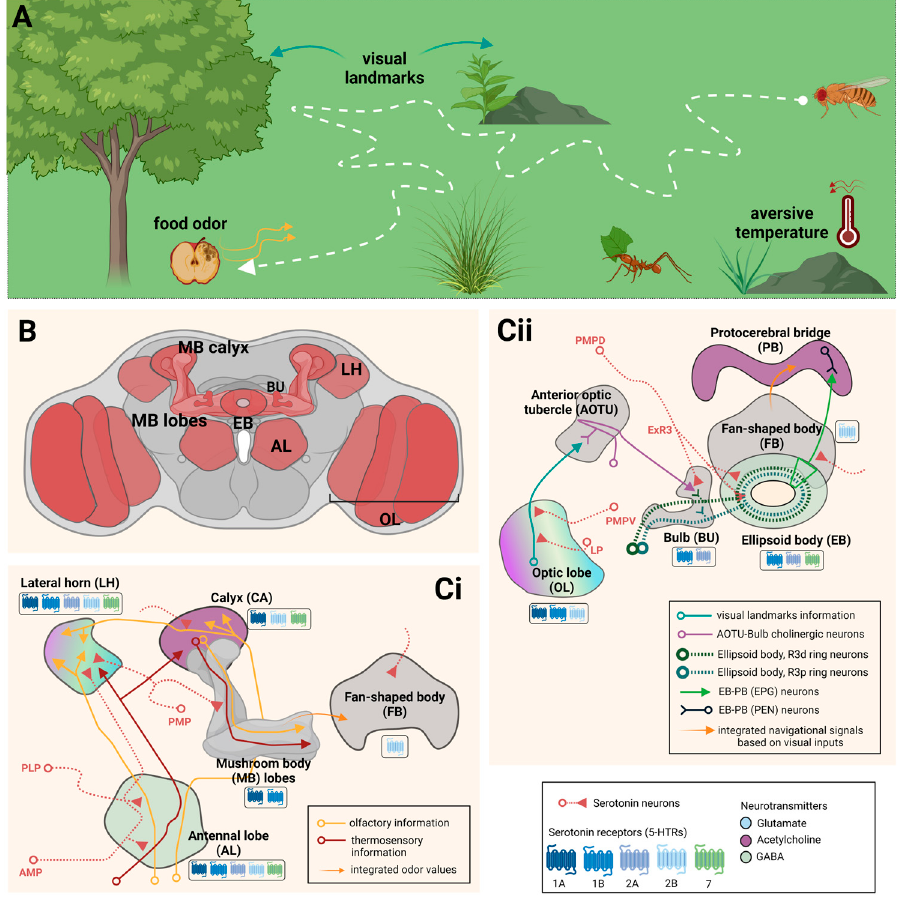
Figure 3. Schematic diagram of neural circuits underlying non-visual- and visual-spatial navigation. ( A ), Flies use navigational strategies involving information provided by different environmental factors, including sensory cues such as food odors (orange arrows), temperature (red arrows), and visual landmarks (dark cyan arrows). ( B ), Scheme showing diverse brain neuropils in the fly brain (in red) that receive and/or process information associated with spatial navigational memories, and are innervated by serotonergic fibers. ( C ), Representation of serotonergic modulation of neural circuits related to sensory and memory processing of non-visual ( Ci ) and visual ( Cii ) information. In boxes are indicated the serotonergic receptors expressed in each fly brain area. Neurons that project to different target areas or that are of different neurochemical identity, are represented in different colors. The graphical schemes were drawn with information published in [61,62,87].